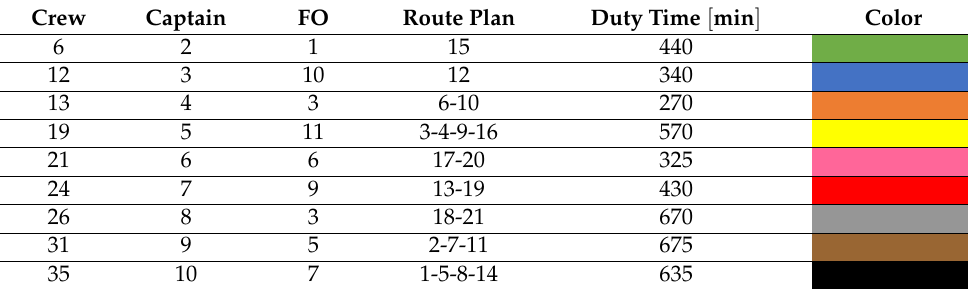
Table 14. Routes of active crews after operational